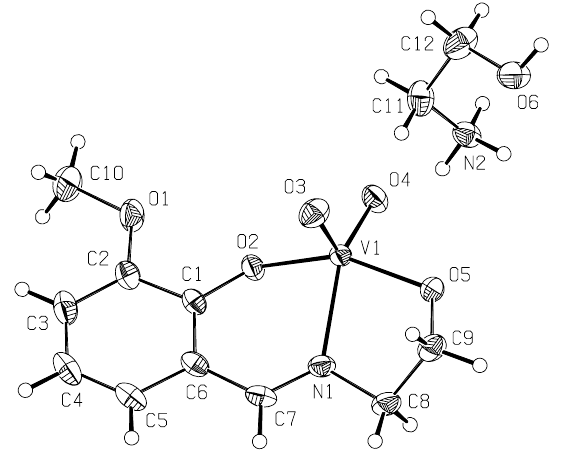
Table 1. Data collection and handling.